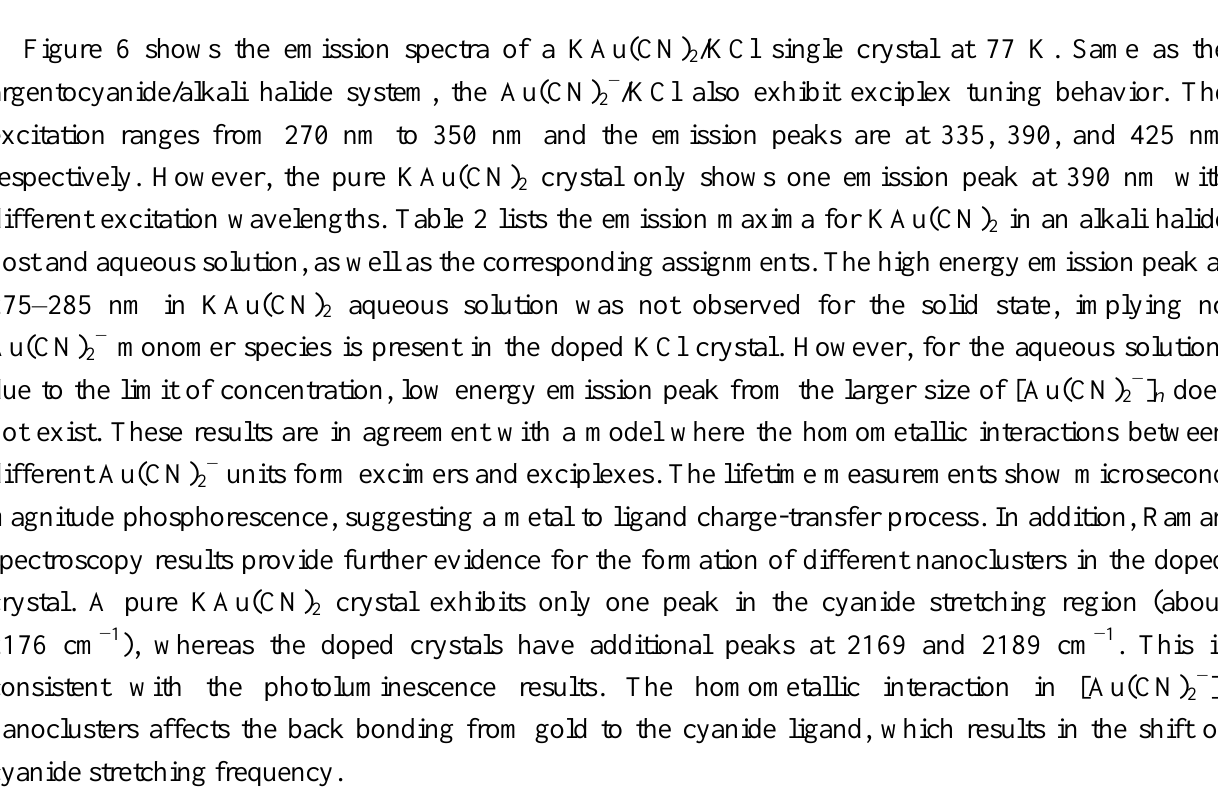
/KCl at 77 K with different 2